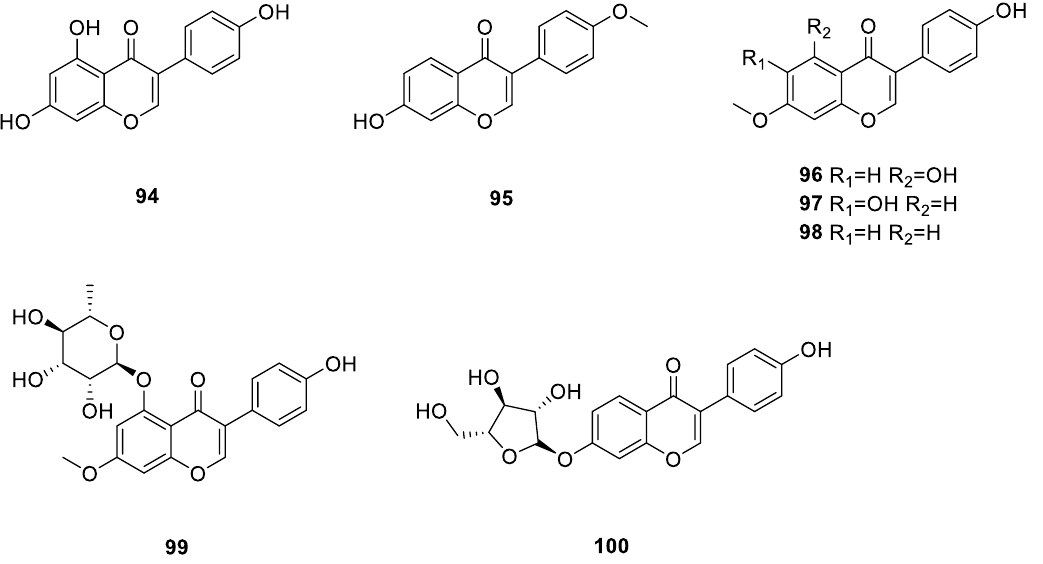
Figure 11. Chemical structures of compounds 94 − 100 from lichen-associated actinomycetota.